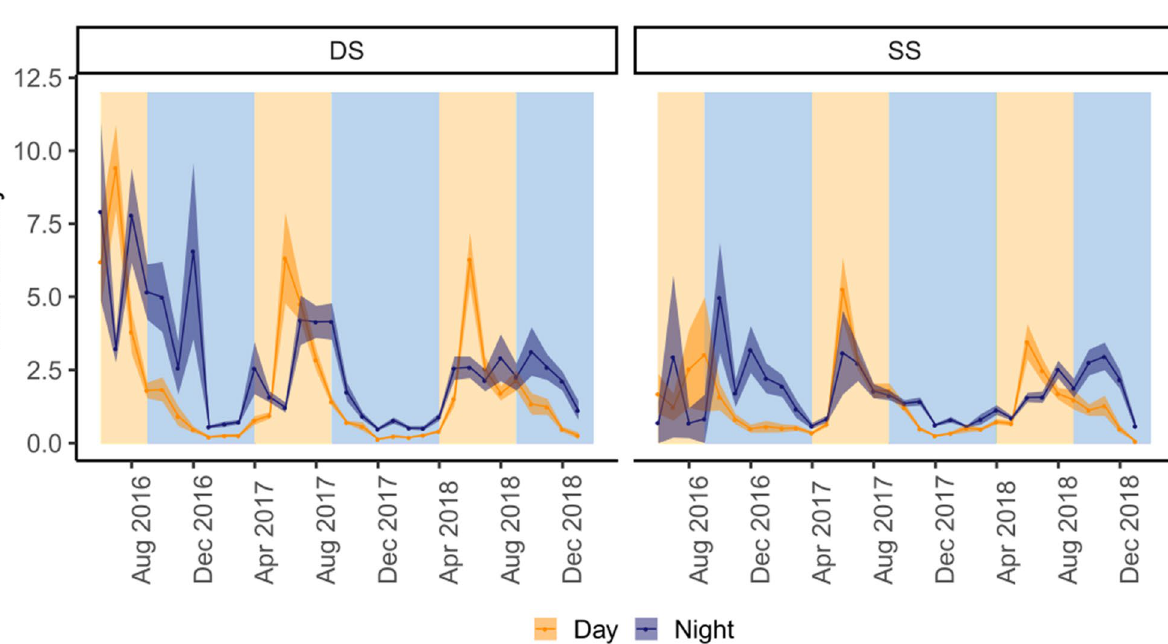
Figure 8. Monthly mean fish activity of each group per day and night, over the study period. SS shallow/ shallow, DS deep/shallow. Background colors represent cold and warm periods in blue and light orange, respectively.